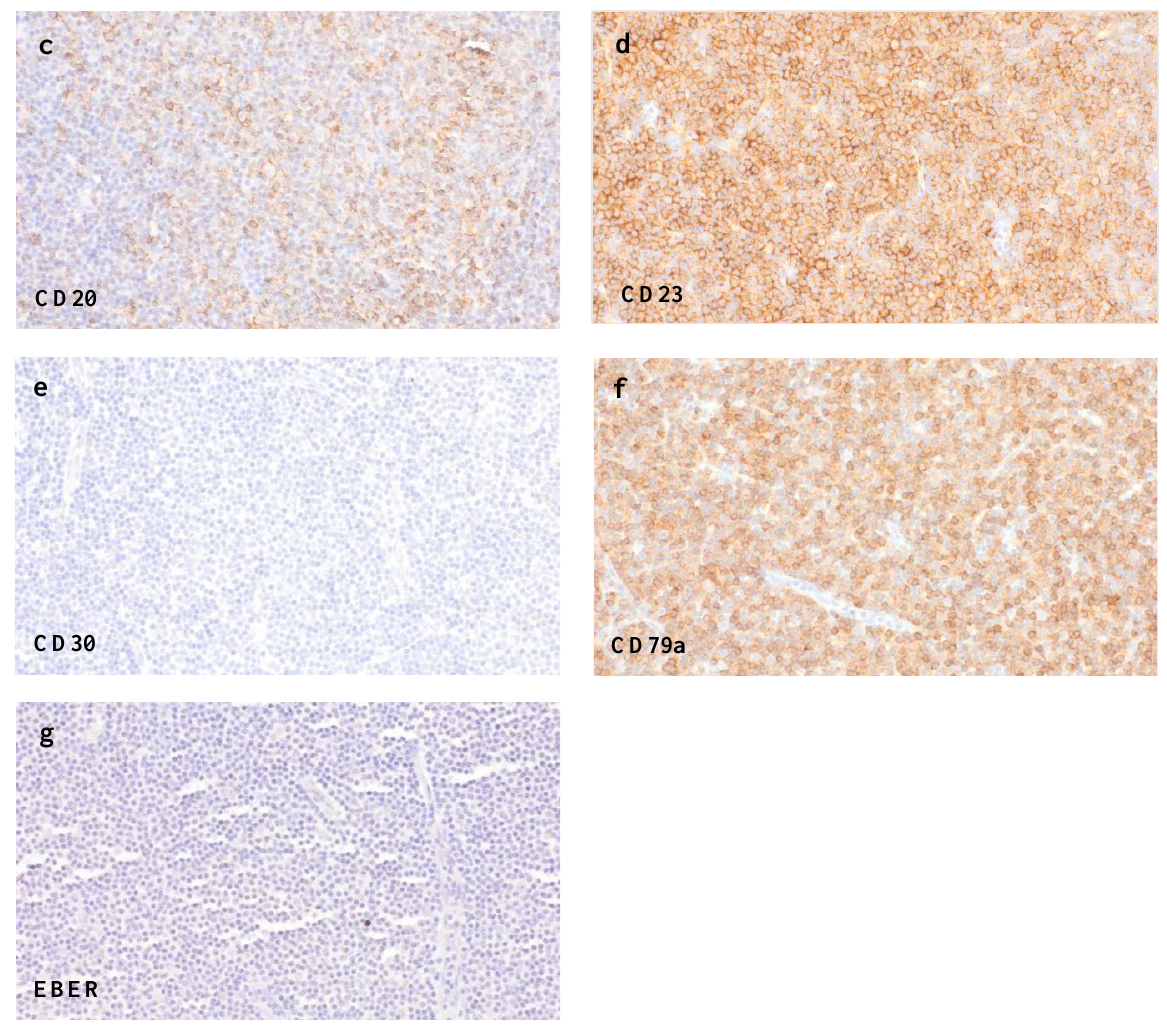
Figure 5. CLL/SLL infiltration of the lymph node. Tissue samples of the removed cervical lymph node, showing a dense cell infiltrate of small lymphocytes (( a ), H&E staining, 400×) with a co- expression of CD5 (( b ), 400×), CD20 (( c ), 400×), CD23 (( d ), 400×) and CD79a (( f ), 400×). CD30 (( e ), 400×) remained negative, and only single small EBV-positive bystander cells were seen in EBER in situ hybridization (( g ), 400×).